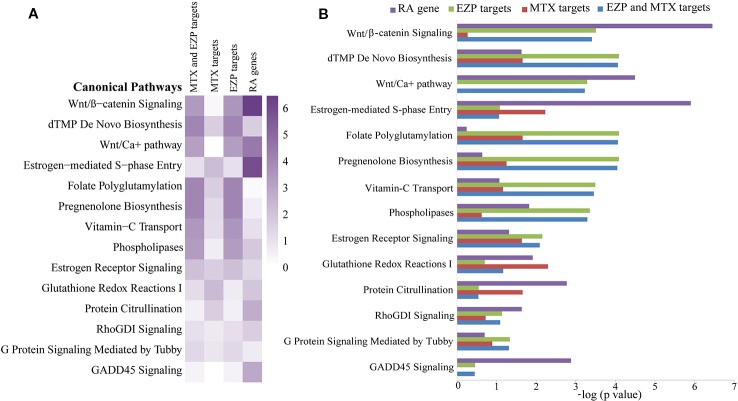
The results of bioinformatic analysis. Signaling pathways shared among the gene molecular networks related to rheumatoid arthritis (RA) and the protein target molecular networks of EZP and MTX in the context of cytokine and cellular immune signaling, identified by using the Ingenuity Pathway Analysis (IPA) compare module. The Wnt/β-catenin signaling pathway was the pathway focused on. (A) Heat map of the top 14 shared signaling pathways of EZP, MTX, and RA. (B) Bar graph of the top 14 shared signaling pathways of EZP, MTX, and RA.